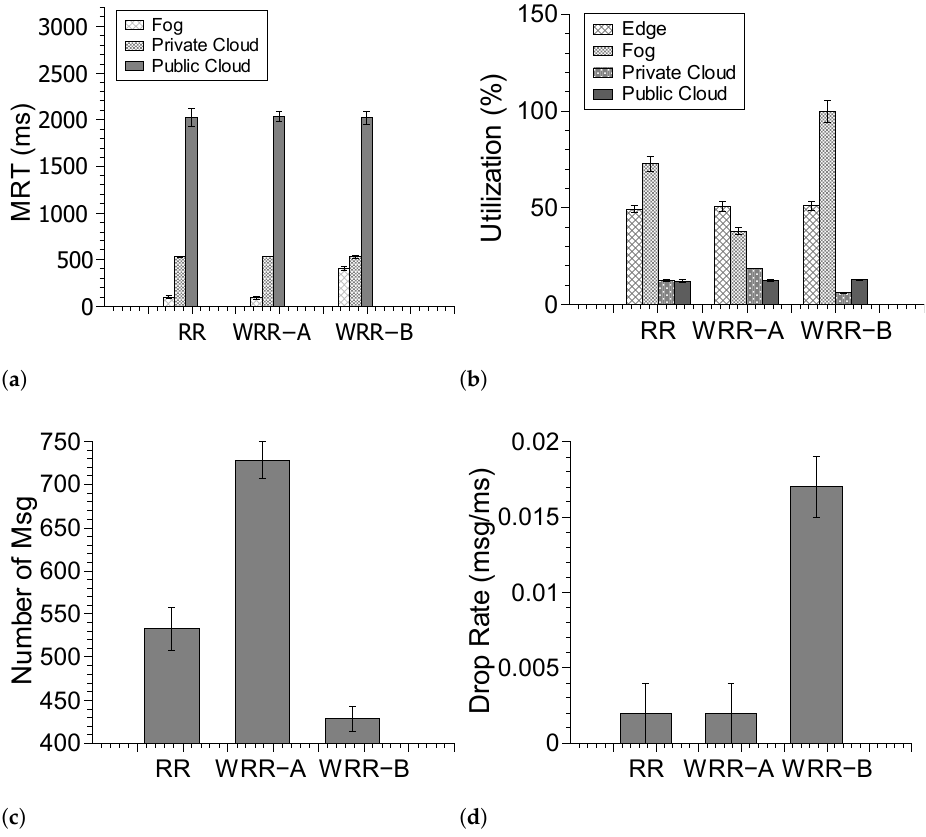
Figure 7. Simulation results with the proposed model considering different load balancing algorithms. ( a ) Mean response time. ( b ) Utilization. ( c ) System number of messages. ( d ) Drop